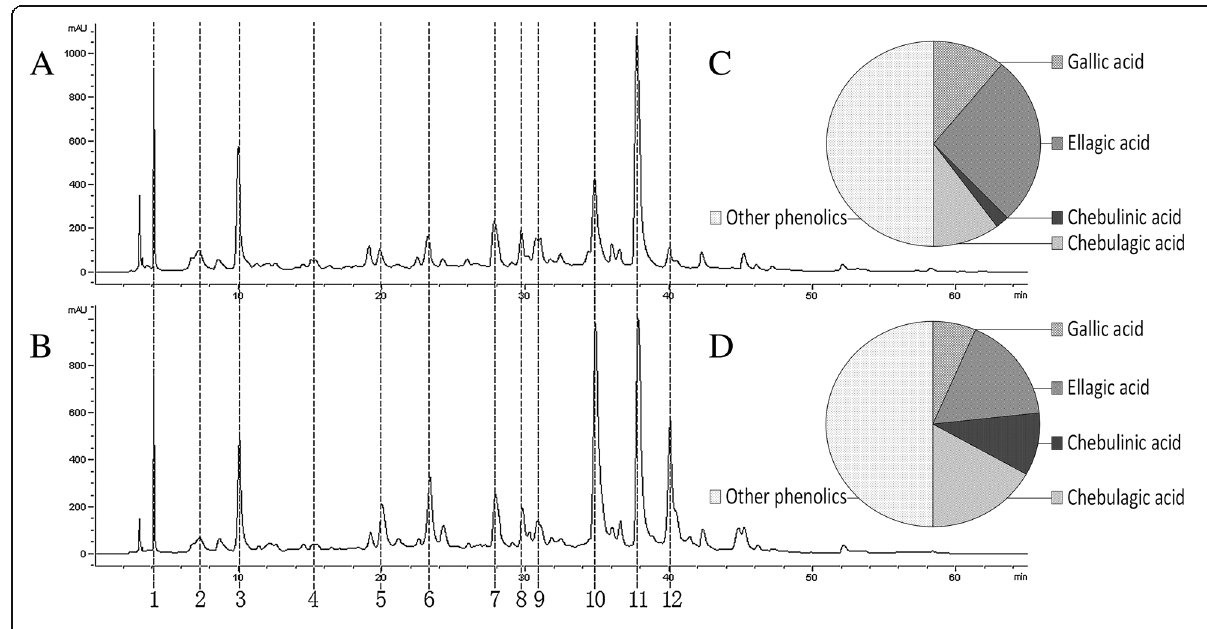
Fig. 1 Comparison of the contents of components between the superior and inferior triphala extracts, as determined by HPLC. a HPLC chromatogram of the superior triphala preparation; b HPLC chromatogram of the inferior triphala preparation; c approximation of the contents of the superior triphala preparation based on the area percent by HPLC; and d approximation of the contents of the inferior triphala preparation based on the area percent by